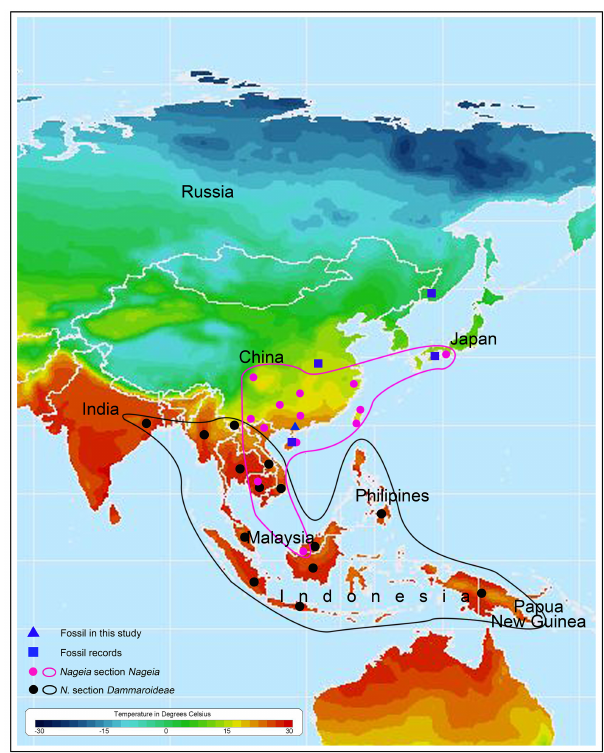
Figure 1. Map showing the distribution of extant and fossil Nageia and their mean annual temperature (modified after the map from http://nelson.wisc.edu/sage/data-and-models/atlas/maps/